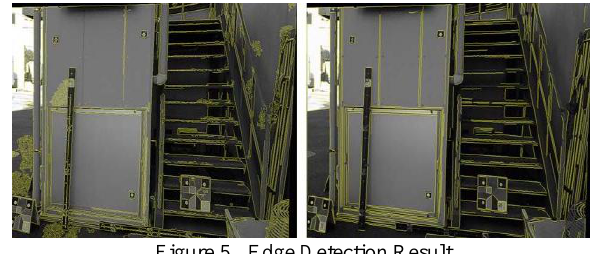
Figure 5. Edge Detection Result